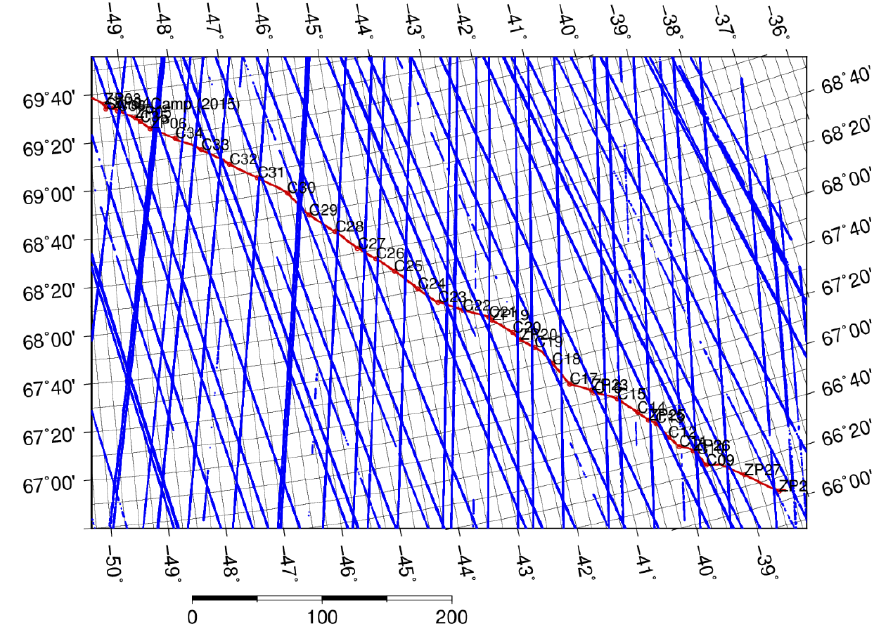
Figure 15. Coverage of the operation area by the IceSat mission (2003–2010). The diagonal line represents the profile measured by GKE on the ground.